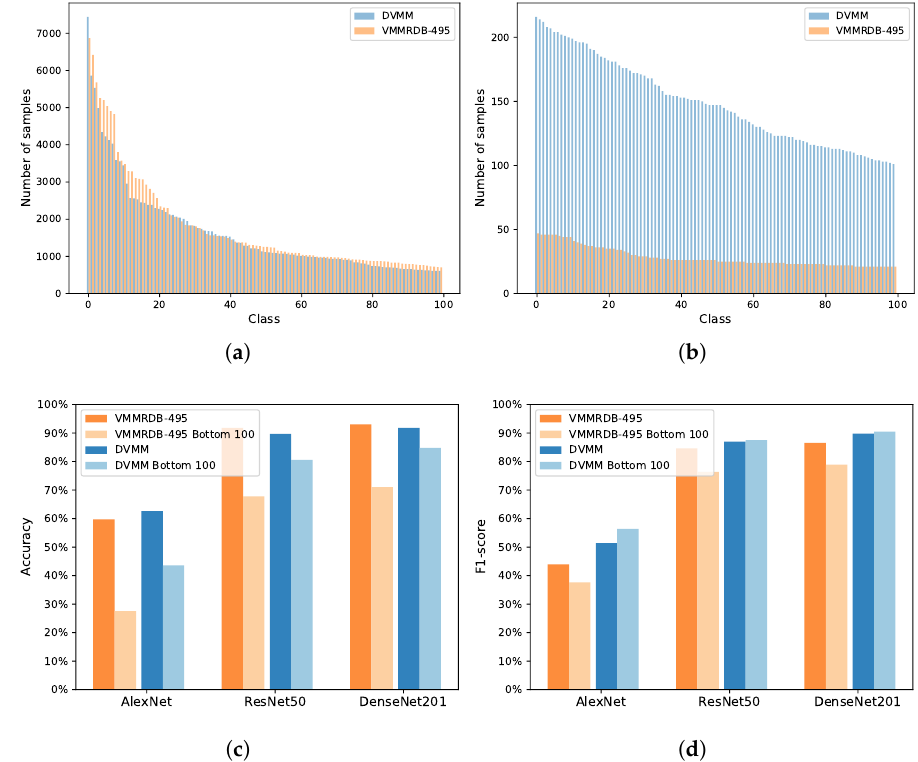
Figure 4. Distribution of model classes in the VMMRDB-495 [4] and DVMM datasets: ( a ) Top- 100 classes (most populated); ( b ) Bottom-100 classes (least populated). Performance